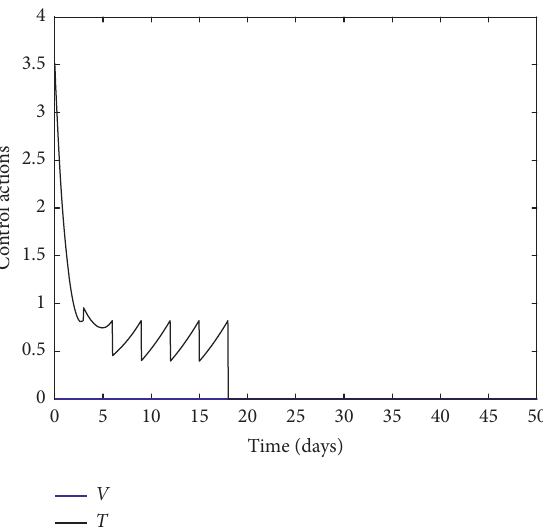
Figure 14: Control efforts when Δ t � 72 hours and n � 20